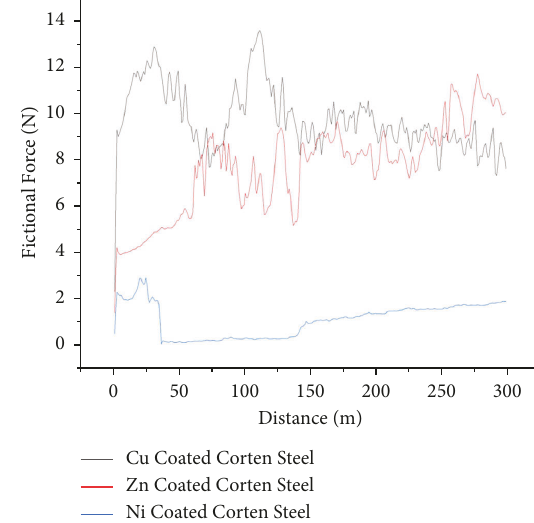
Figure 14: Wear frictional force of electroplated corten